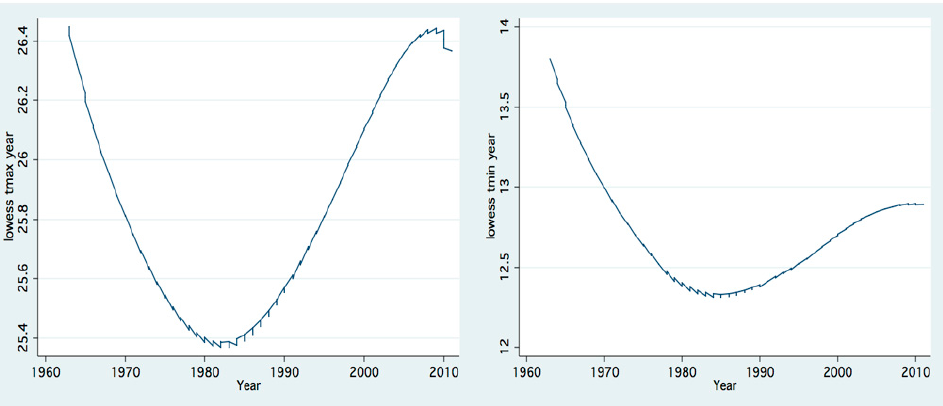
Figure 16. Trend of temporal (1963–2011) changes (LOWESS;0.8) of annual averages of daily maxima (upper) and minima (lower) of air temperatures Dafna meteorological station.